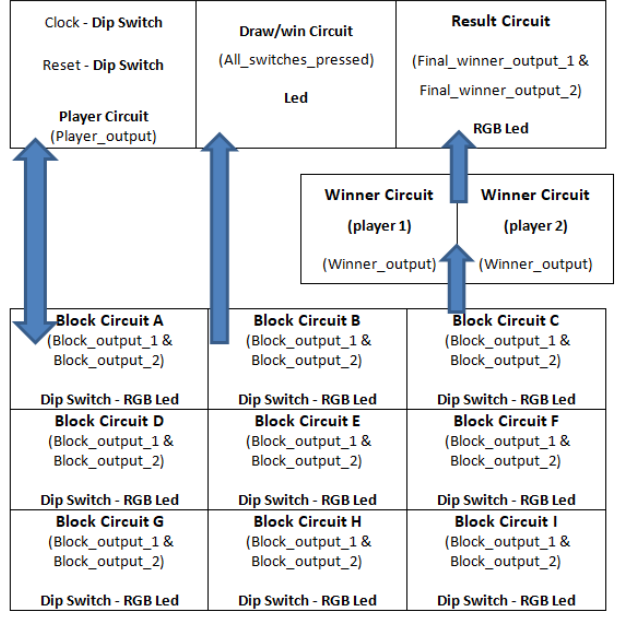
Figure 2. Functionality of